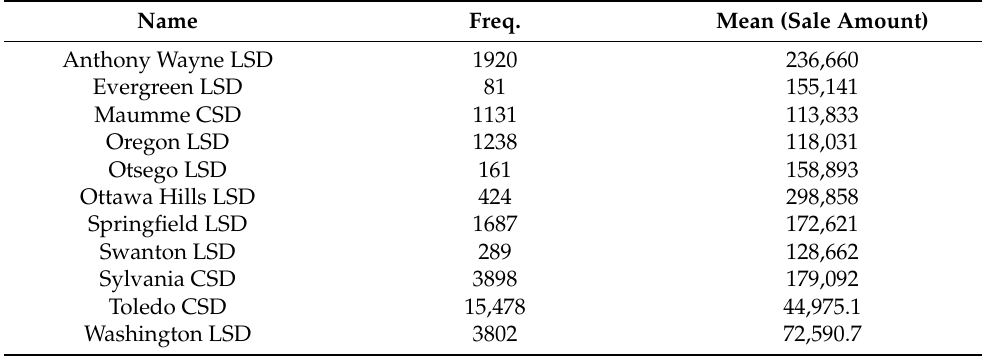
Table 4. House price changes significantly with different school